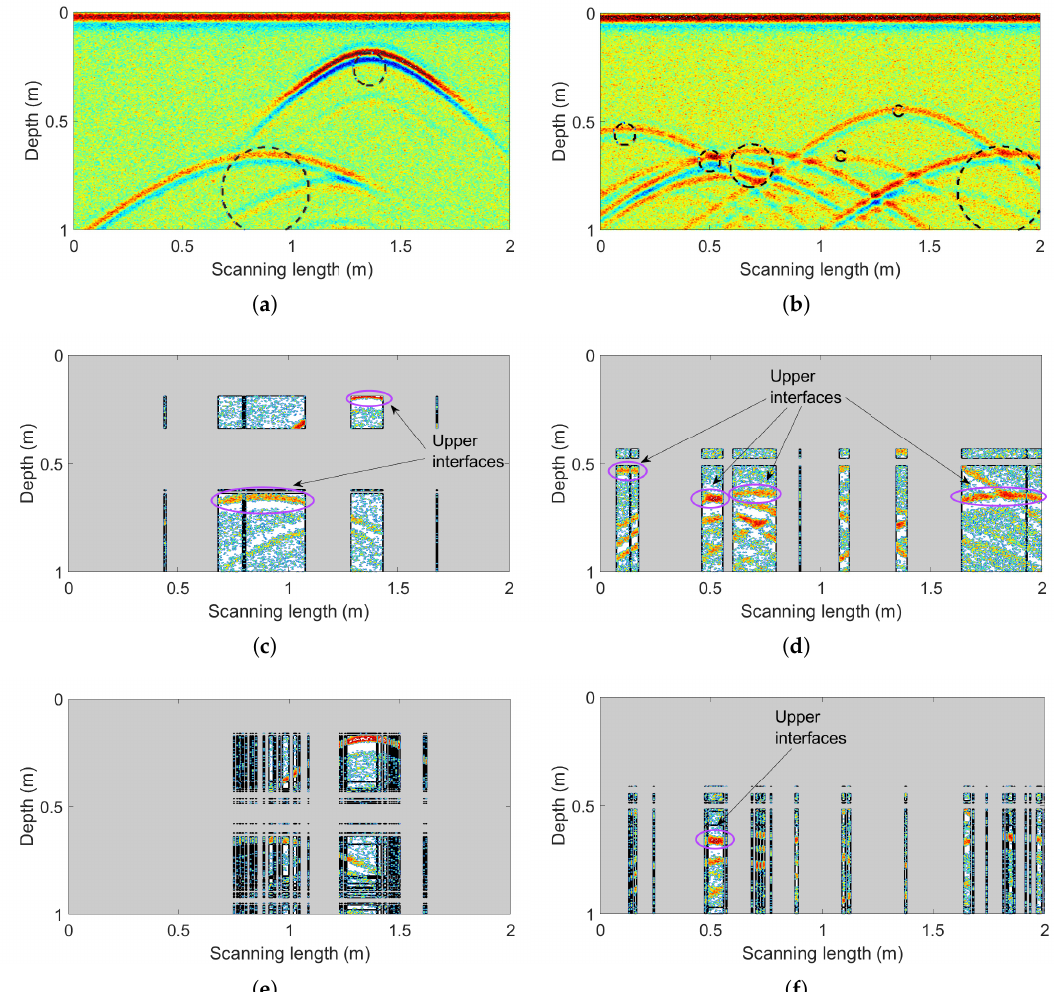
Figure 12. ( a ) The example noisy profile with two pipelines (central coordinates and diameters ((1.355 m, 0.263 m), 0.15 m) & ((0.875 m, 0.823 m), 0.4 m)). ( b ) The example noisy profile with six pipelines (left five central coordinates and diameters ((0.12 m, 0.56 m), 0.1 m), ((0.505 m, 0.658 m), 0.1 m), ((0.695 m, 0.705 m), 0.2 m), ((1.1 m, 0.66 m), 0.05 m) & ((1.365 m, 0.453 m), 0.05 m), and rightest height and width (0.385 m, 0.37 m)). ( c ) The reconstructed profile of panel (a) by the proposed learning framework. ( d ) The reconstructed profile of panel (b) by the proposed learning framework. ( e ) The reconstructed profile of panel (a) after the independent SVM for comparison. ( f ) The reconstructed profile of panel (b) after the independent SVM for